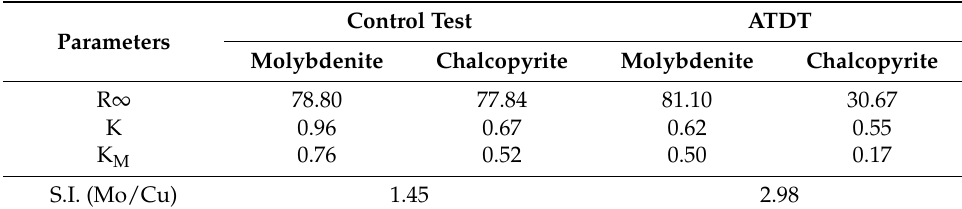
Table 1. Model parameters of the model fits.